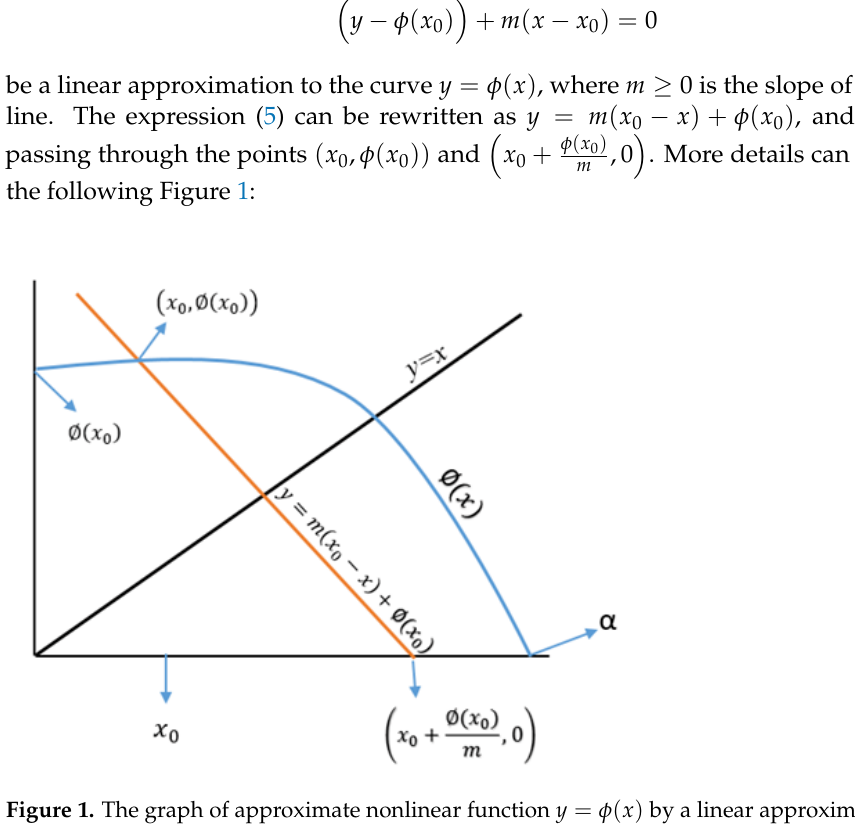
Figure 1. The graph of approximate nonlinear function y = φ ( x ) by a linear